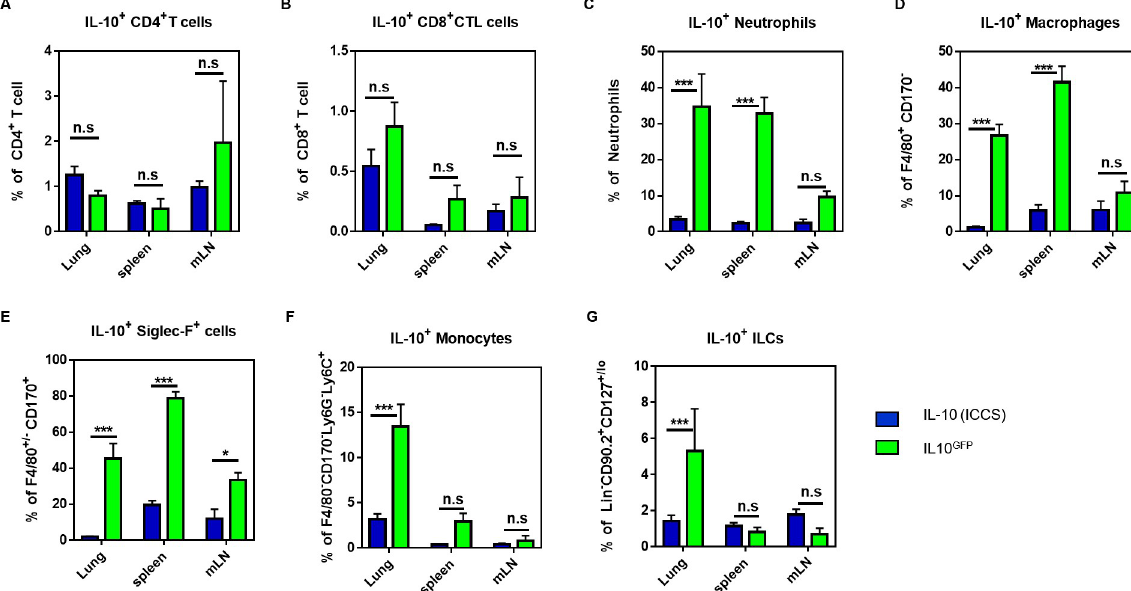
Fig 2. The myeloid-derived IL-10 GFP signal is masked by autofluorescence in granulocytes. C57BL/6 and IL-10 GFP mice were challenged three times (d0, d1, d2) with either PBS or 10 μ g LPS per mouse via aspiration. 16–18 hours after the last administration, the single cell suspension from lungs, spleens, and mLNs were stained for CD4 + T cells (CD45 + CD45R/B220 - CD3 ε + CD4 + CD8 α - ), CD8 + T cells (CD45 + CD45R/B220 - CD3 ε + CD4 - CD8 α + ), macrophages (CD45 + CD45R/B220 - CD3 ε - Siglec-F - F4/80 + ), Siglec-F + cells (eosinophils, alveolar macrophages; CD45 + CD45R/B220 - CD3 ε - Siglec-F + F4/80 -/+ ), neutrophils (CD45 + CD45R/B220 - CD3 ε - Siglec-F - F4/80 - Ly6G + CD11b + ), monocytes (CD45 + CD45R/B220 - CD3 ε - Siglec-F - F4/80 - Ly6G - Ly6C + CD11b + ), and ILCs (CD45 + CD45R/B220 - CD3 ε - Siglec-F - F4/80 - Ly6G - CD90.2 + CD127 lo/- ). The expression of IL-10 was measured either by GFP + or by intracellular IL-10 as indicated. (A-G) Comparison of the IL- 10 signal derived from intracellular cytokine staining (ICCS) or from the GFP-signal (IL10 GFP ) of IL10 GFP mice in (D) CD4 + T cells, (E) CD8 + T cells, (F) neutrophils, (G) macrophages, (H) Siglec-F + cells (eosinophils, alveolar macrophages), (I) monocytes, and (J) ILCs from indicated organs. The graph shows combined data from two independent experiments (PBS: n = 6 mice/group, LPS: n = 7–9 mice/group in total).